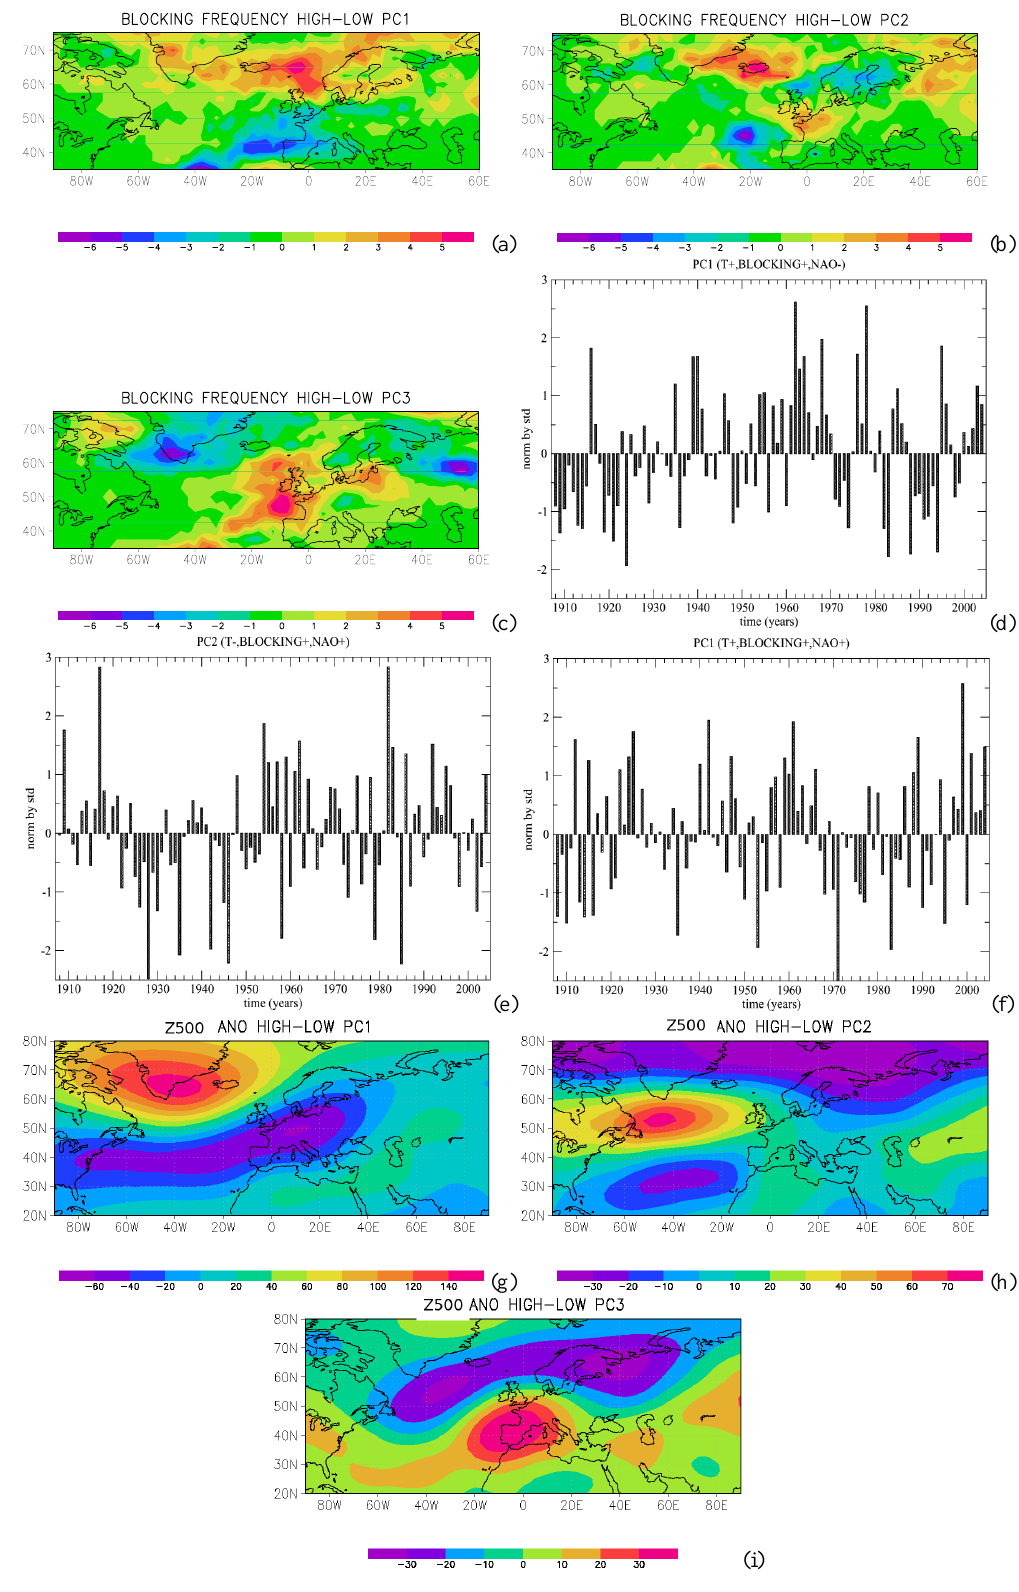
Fig. 7. Difference between (a) blocking frequency and (g) Z500 corresponding to high and low values of PC1 of T , blocking and NAO indices represented in (d) . (b) , (e) and (h) as in (a) , (d) and (g) but for PC2. (c) , (f) and (i) as in (a) , (d) and g) but for